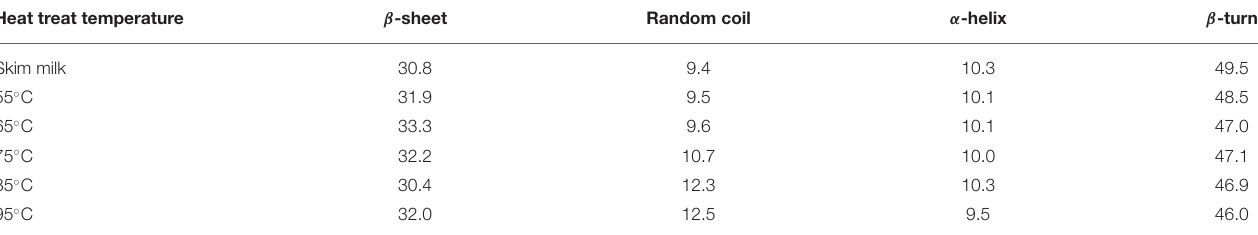
TABLE 1 | Percentage of secondary structures of skim milk heat-treated at different temperatures. Heat treat temperature β -sheet Random coil α -helix β -turn Skim